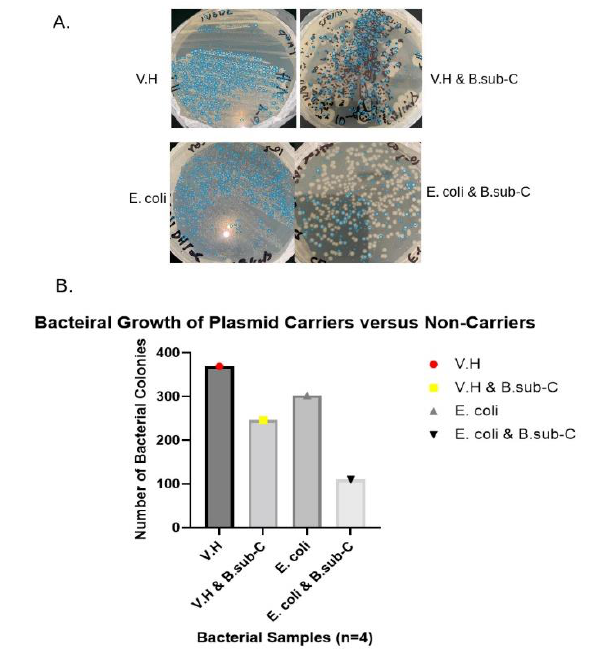
Figure 1 : The Colony Forming Units (CFU/mL) After dilution series for each sample were generated, the CFU/mL were allocated. Each dilution series showed a large decrease in CFU/mL for B.subtilis-Carrier-V.H compared against the V. harveyi only bacterial sample culture. A. A significant decrease in bacterial growth occurred for the B.subtilis-Carrier-V.H-E.Coli co-culture assays. B. V.H CFU/mL dwindled from 3.69B to 2.46B when V. harveyi was co-cultured with B.subtilis plasmid carriers. E. Coli, when co-cultivated with plasmid carrier B.subtilis, displayed a significant decrease in CFU/mL from 3.02M to